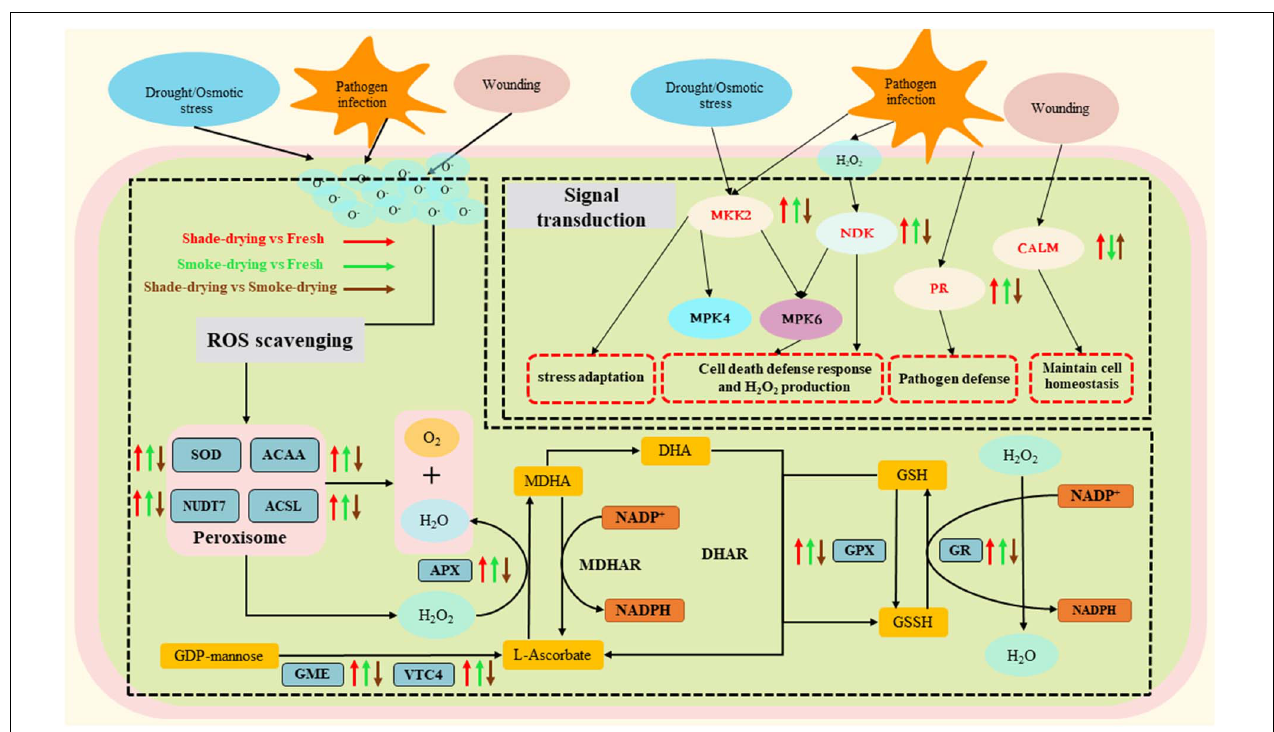
FIGURE 8 | Overview of the important differentially expressed proteins of the stress response and signal transduction involved in rhubarb during the dry process. The arrow up represents the up-regulation of proteins. The arrow down represents the down-regulation. MKK2, mitogen-activated protein kinase kinase; NDK, nucleoside diphosphate kinase; PR, pathogenesis-related protein 1; CALM, calmodulin; SOD, superoxide dismutase; ACAA, acetyl-CoA acyltransferase; NUDT7, peroxisomal coenzyme A diphosphatase NUDT7; ACSL, long-chain acyl-CoA synthetase; APX, L-ascorbate peroxidase; GPX, glutathione peroxidase; GR, glutathione reductase; GME, GDP- D -mannose 3 (cid:48) ,5 (cid:48) -epimerase; VTC4, inositol-phosphate phosphatase; MDHAR, MDHA reductase; DHAR, dehydroascorbate reductase; MDHA, monodehydroascorbate; DHA, dehydroascorbate; GSH, reduced glutathione; GSSH, oxidized glutathione; NADP + /NADPH, nicotinamide adenine dinucleotide